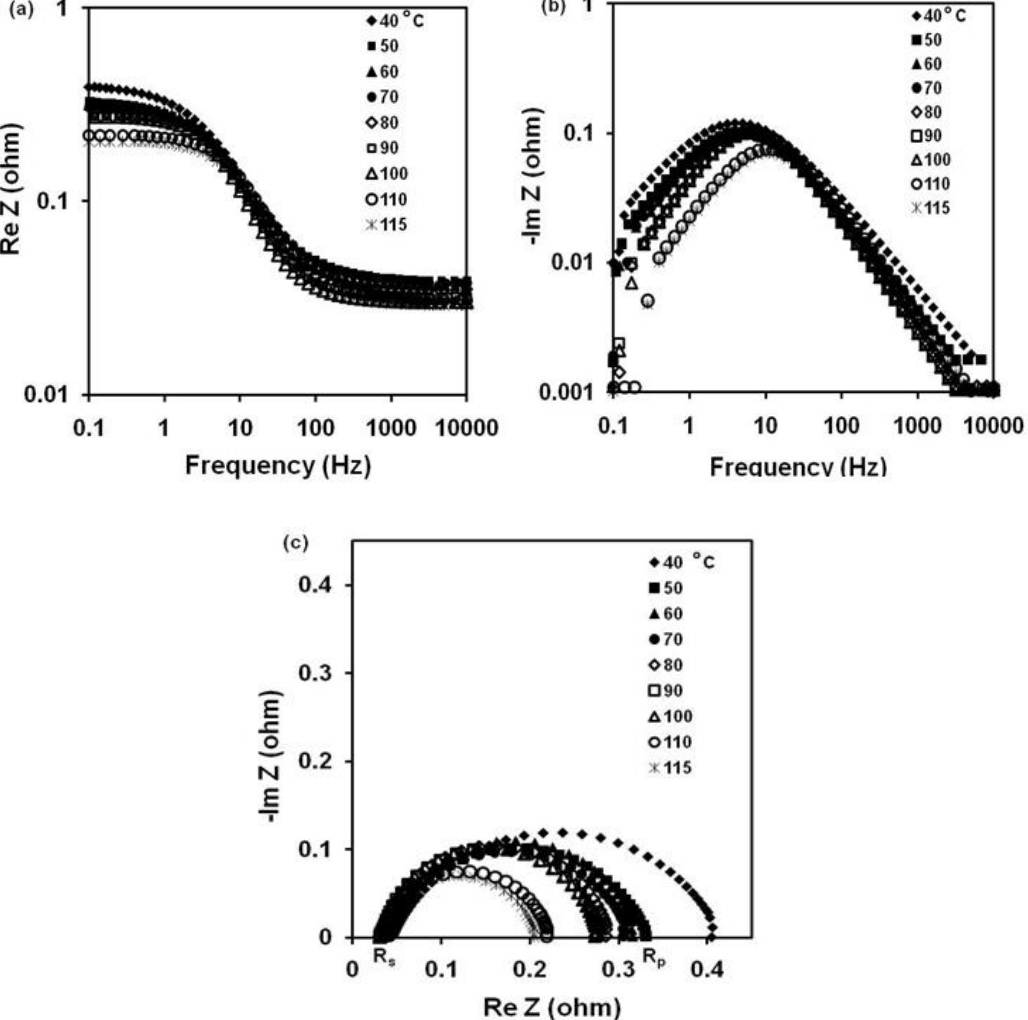
Figure 11. Plots of ( a ) log-log storage impedance versus frequency and ( b ) log-log loss impedance versus frequency of 90/10 Nafion/HBPEAc-COOH at 74% RH measured from 30 to 100 °C with 10 °C increment; and ( c ) Cole-Cole plots of 90/10 Nafion/HBPEAc-COOH impregnated membranes generated at 74% RH. The diameter of semi-circular plots shrinks with temperature due to lowering of the overall cell